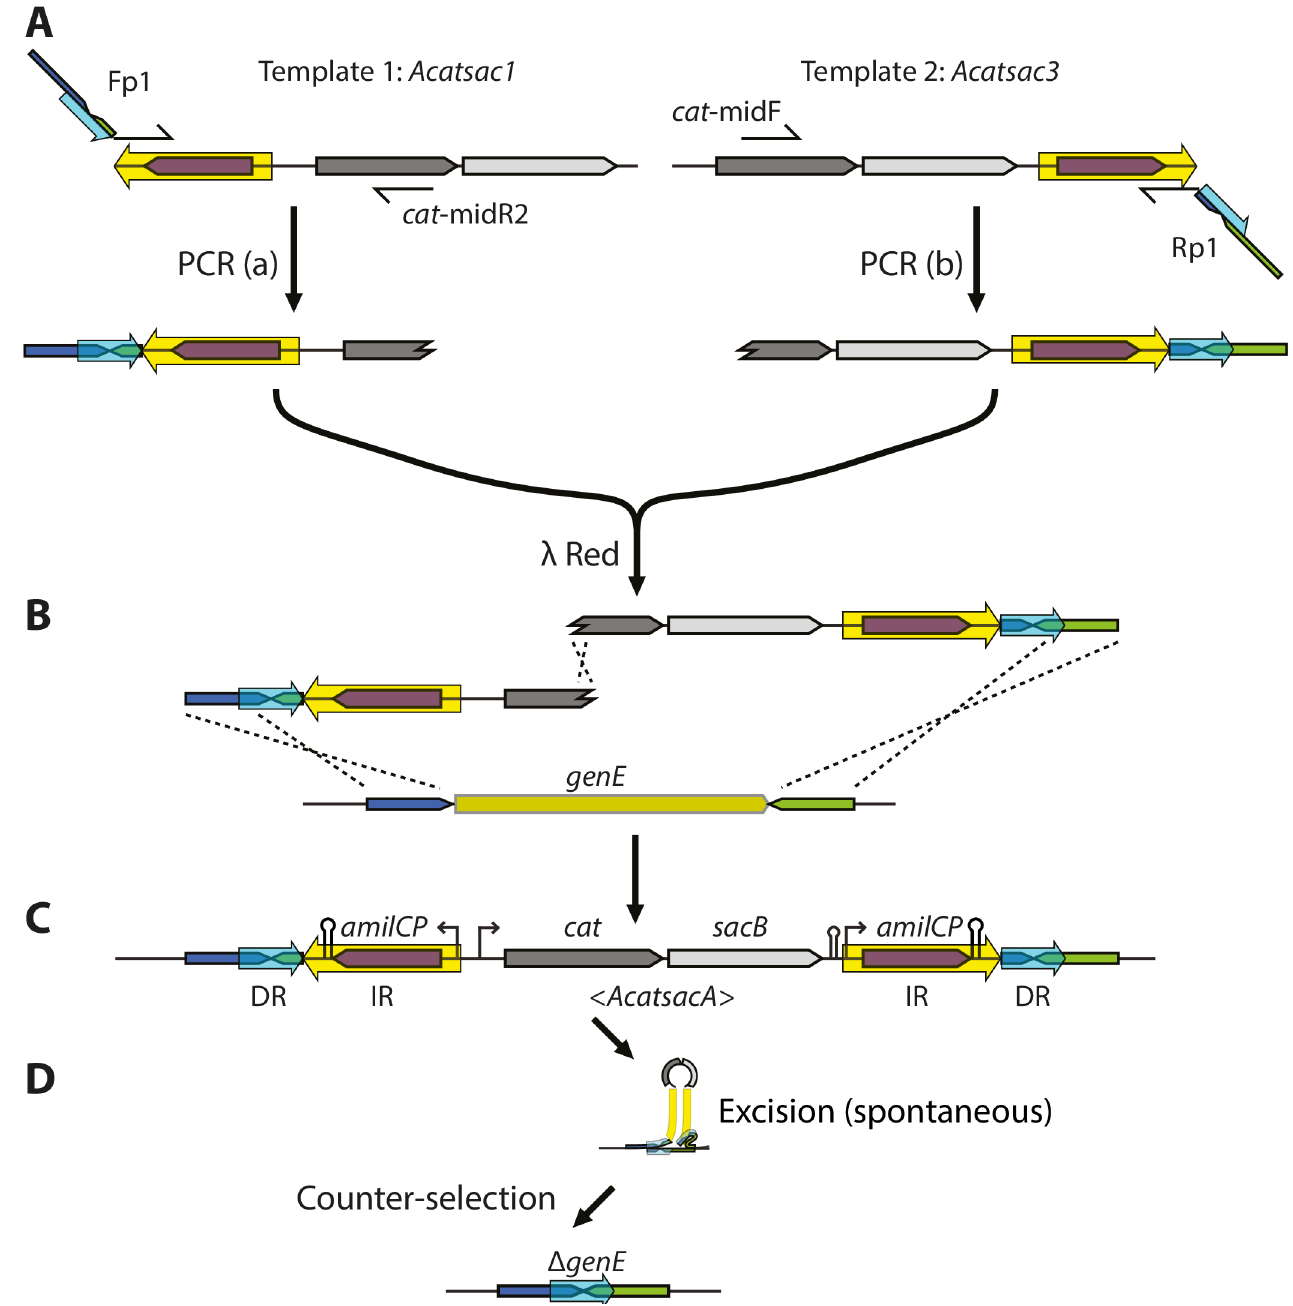
Fig 2. Overview of the method. The method is illustratedwith an examplefor generatinga precise deletion of a hypothetical gene. (A) Two overlapping“half-cassettes” are generatedin separate PCR reactions (which can be run in parallelin the same PCR cycler) using one locus specific long primer “Fp1” or “Rp1” in combination with the cassette specific primers “ cat -midR2”or “ cat -midF”, respectively.Each PCR fragment contain one copy of the IR (yellowarrow) and DR (light blue arrrow), as well as one of the recombinogenic5’-homologyextensions. The templates( Acatsac1 and Acatsac3 ) differ in the locationand orientationof the IR sequence,which containsthe geneencodingthe blue chromoprotein AmilCP. (B) The two “half-cassettes” are mixed in equimolar amountsand electroporated into λ Red inducedcells. For formation of a functional cat gene recombination has to occur betweenthe recombinogenic ends and the chromosome, as well as in the sequenceoverlapbetweenthe two “half-cassettes”. (C) The structure of the semi-stableDIRex intermediate. (D) The structure of the final deletion after spontaneous excisionof the DIRex intermediate (See S3 Fig for a possiblemechanismof